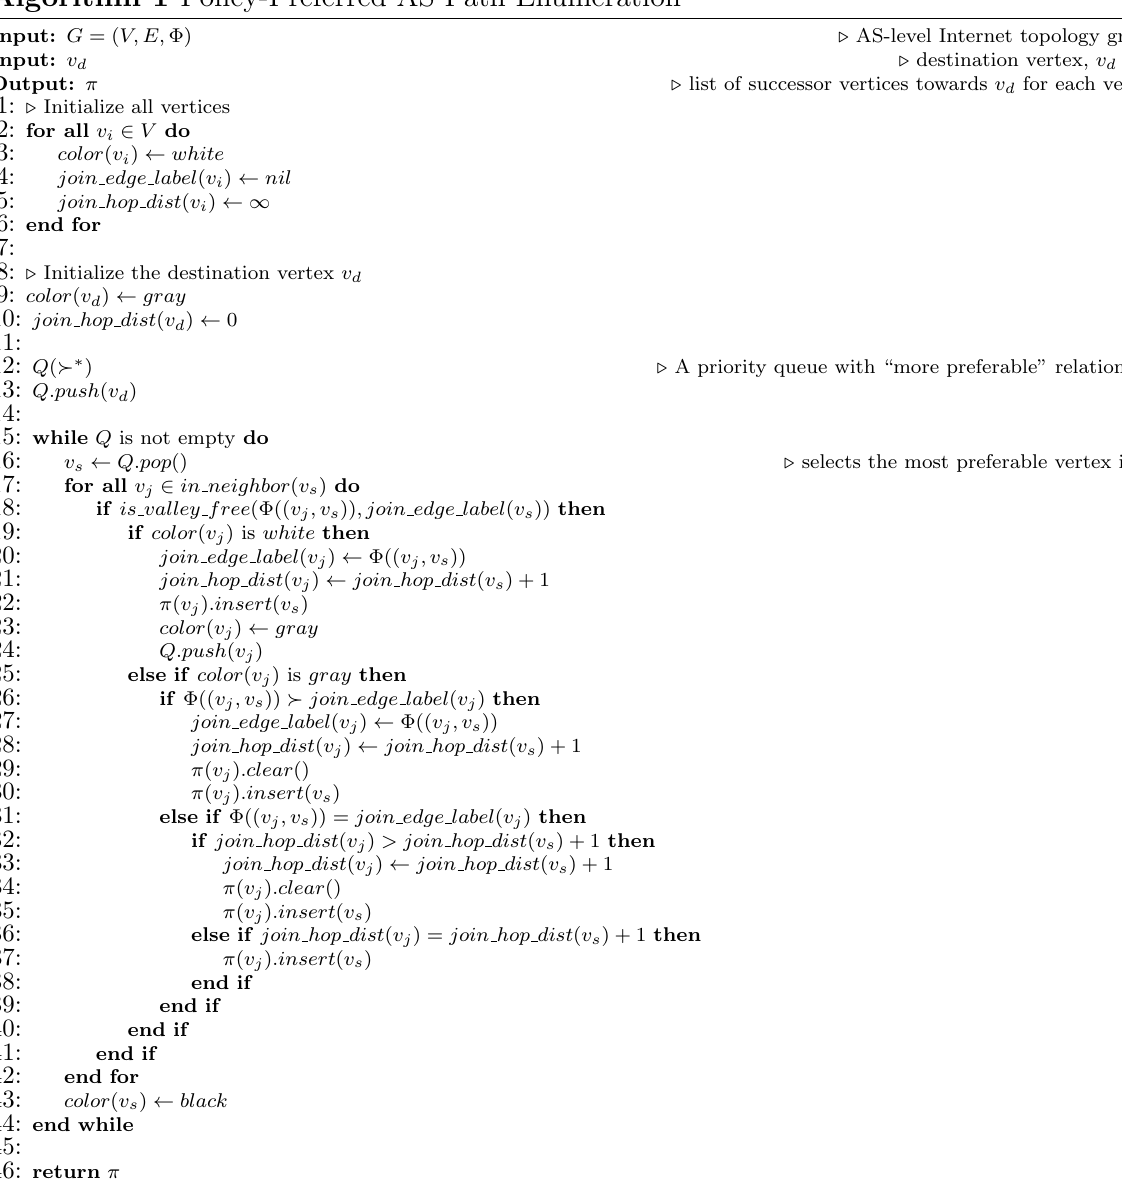
Algorithm 1 Policy-Preferred AS Path